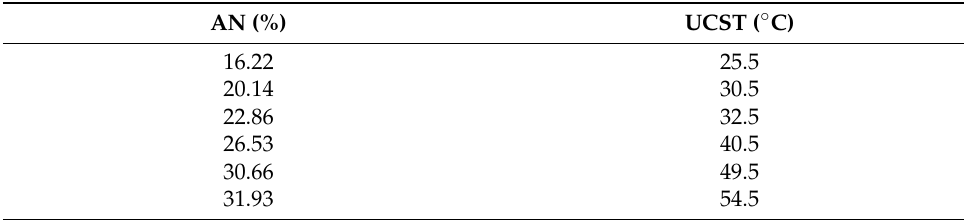
Figure 9. The relationship between the temperature and swelling weight. The AAm grafting degree is 101% of PP-g-PAAm, and the AN concentration of PP-g-P (AAm-co-AN) is 23%. Table 1. UCST of samples with different AN